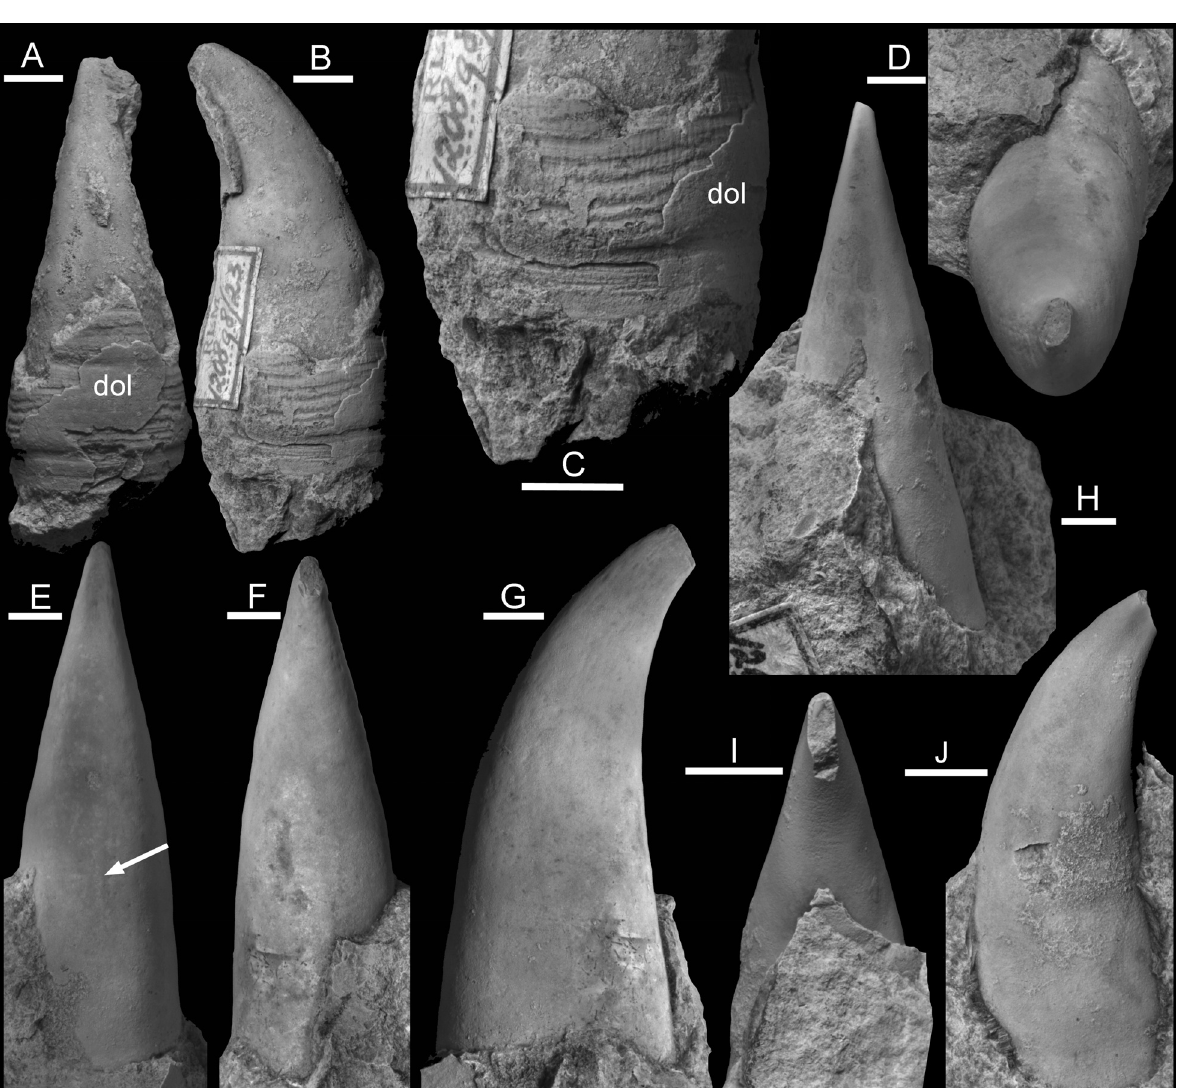
Fig. 2. Pollicina crassitesta Koken, 1897. Ordovician, Darriwilian, Kunda Stage, Tallinn, Estonia. A – C , ELM g8:23 [1208g8/23], lectotype, internal mould with adherent ornamented shell patches and diagenetic outer layer (dol), Domberg (=Toompea): A, supra­ apical surface; B, lateral view; C, detail of lateral surface to show ornamentation. D – G , ELM g8:7 [1208g8/7], internal mould lacking apex, Springthal (=Tondi): D, apical view showing elliptical scar after the broken apex; E, supra­apical surface with median spiral trace arrowed; F, sub­apical surface; G, lateral view. H – J , ELM g8:22 [1208g8/22], internal mould with broken apex, Springthal (=Tondi): H, supra­apical surface; I, sub­apical surface with elliptical scar after broken apex; J, lateral view. Scale bars = 5